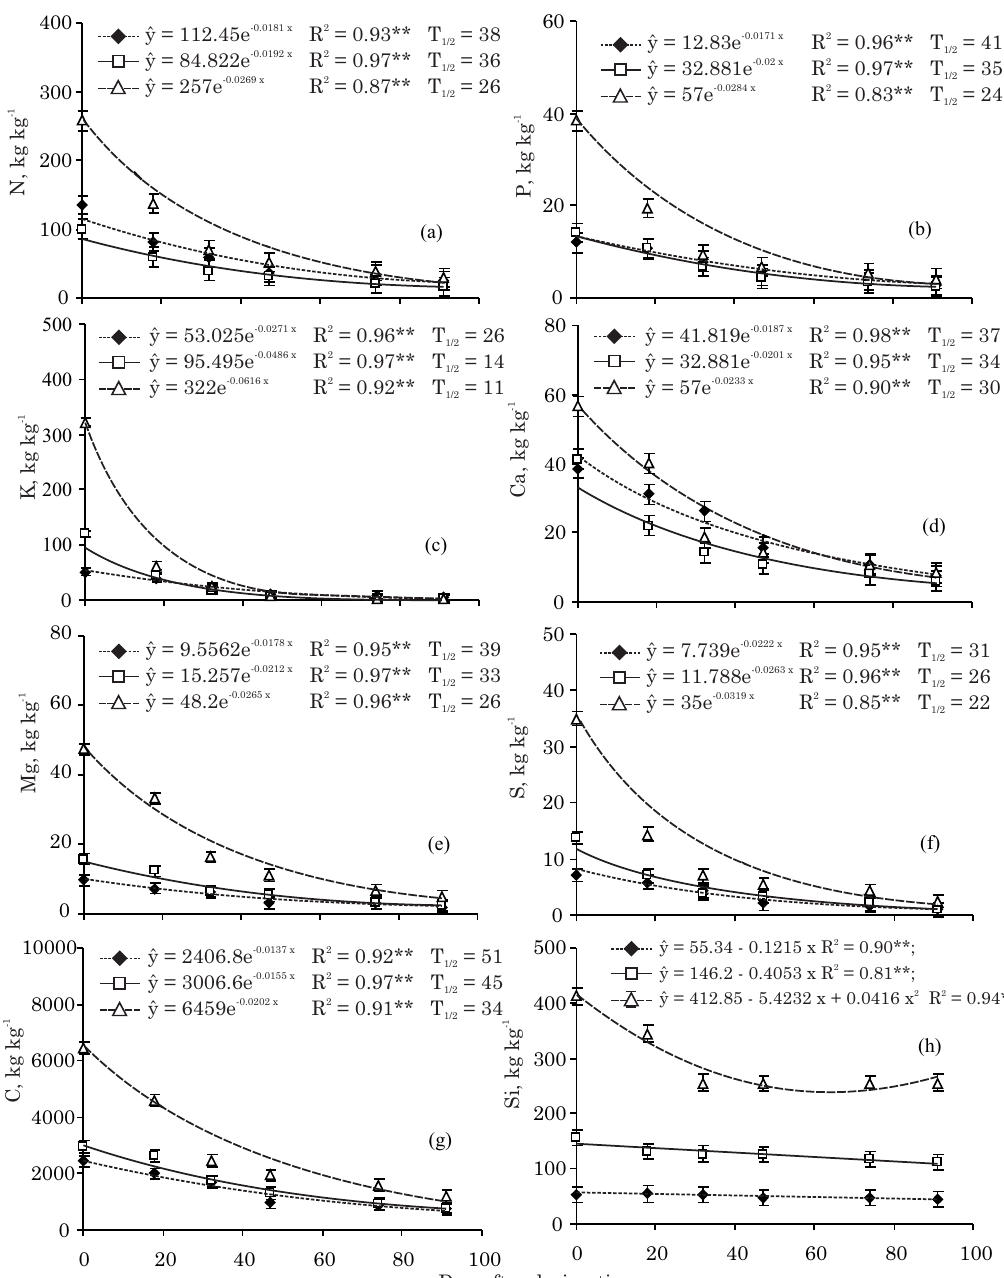
Figure 4. Content remaining of N (a), P (b), K (c), Ca (d), Mg (e), S (f), C (g) and Si (H) in pigeonpea ( ), pigeonpea+pearl millet ( ) and pearl millet ( ) shoot dry matter according to time after desiccation.** significant at 1 % by the F test. T 1/2 refers to the half-life time in DAD. Vertical bars indicate the value of LSD at 5 % by the Tukey